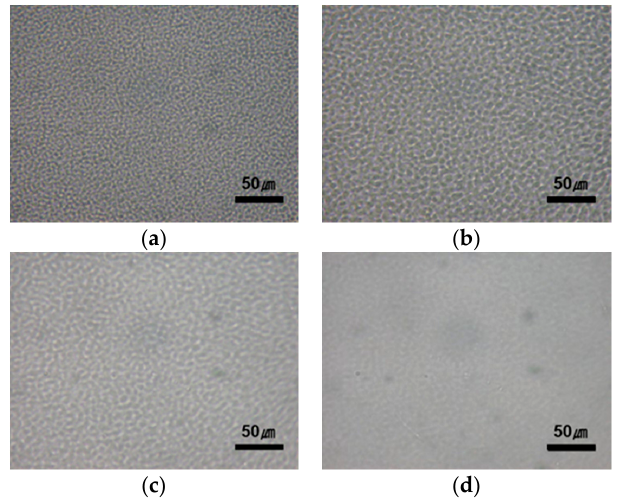
Figure 2. Optical micrographs of the PTT/phenoxy resin blend after annealing at 265 ° C for ( a ) t s = 0.5 min; ( b ) t s = 8 min; ( c ) t s = 15 min; ( d ) t s = 45 min.